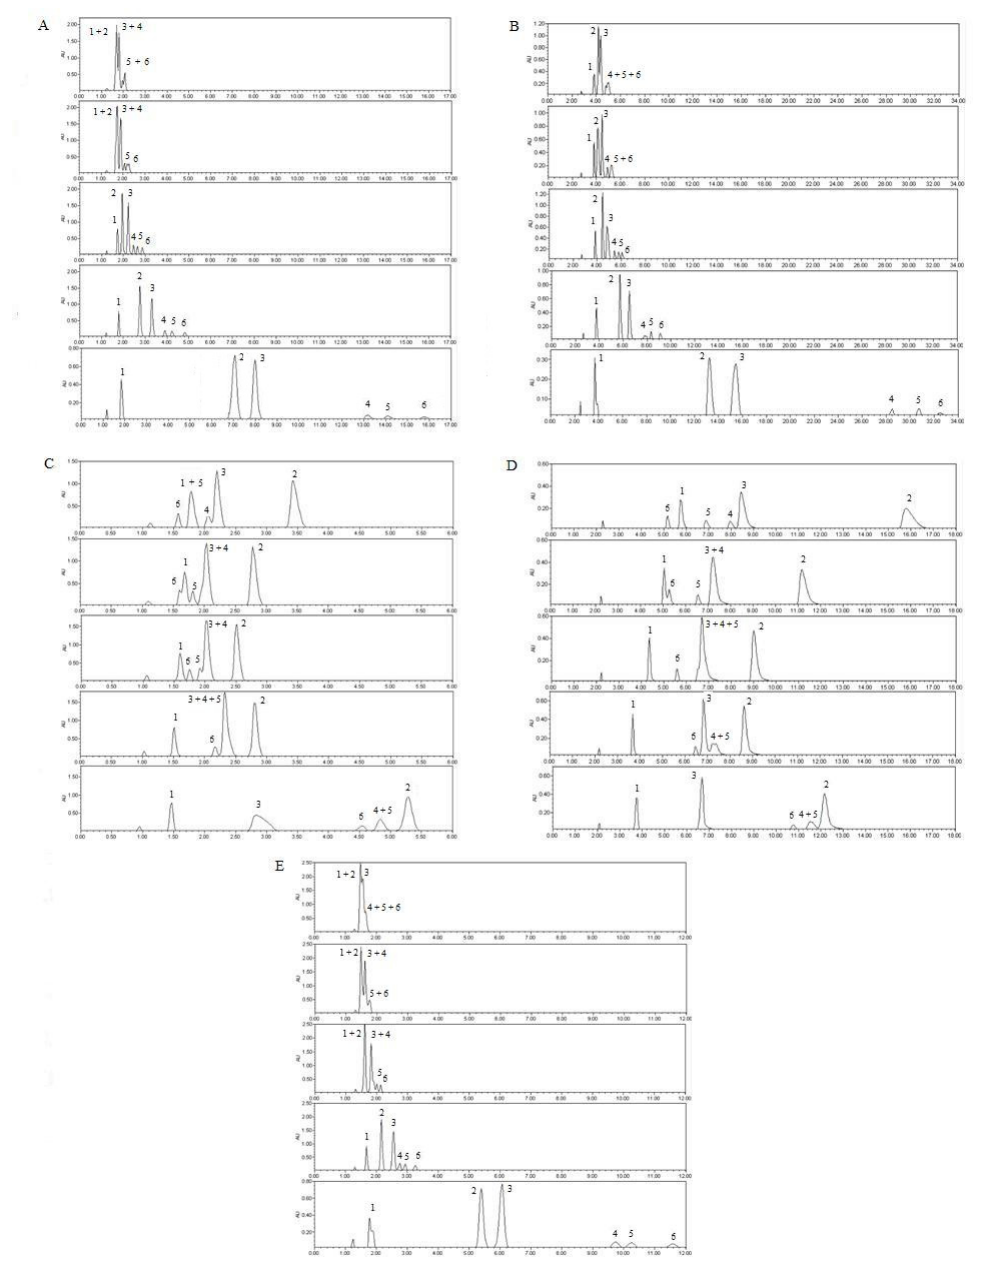
Figure 4. Chromatograms of the analyzed substances on A) Betasil Silica column, B) Bakerbond Silica column, C) Betasil CN column, D) Bakerbond Cyanopropyl column and E) Betasil diol column. Peak identities: 1–lamotrigine, 2–thioridazine, 3–clozapine, 4–chlorpheniramine, 5–pheniramine, 6–sulpiride. For other conditions see Fig.